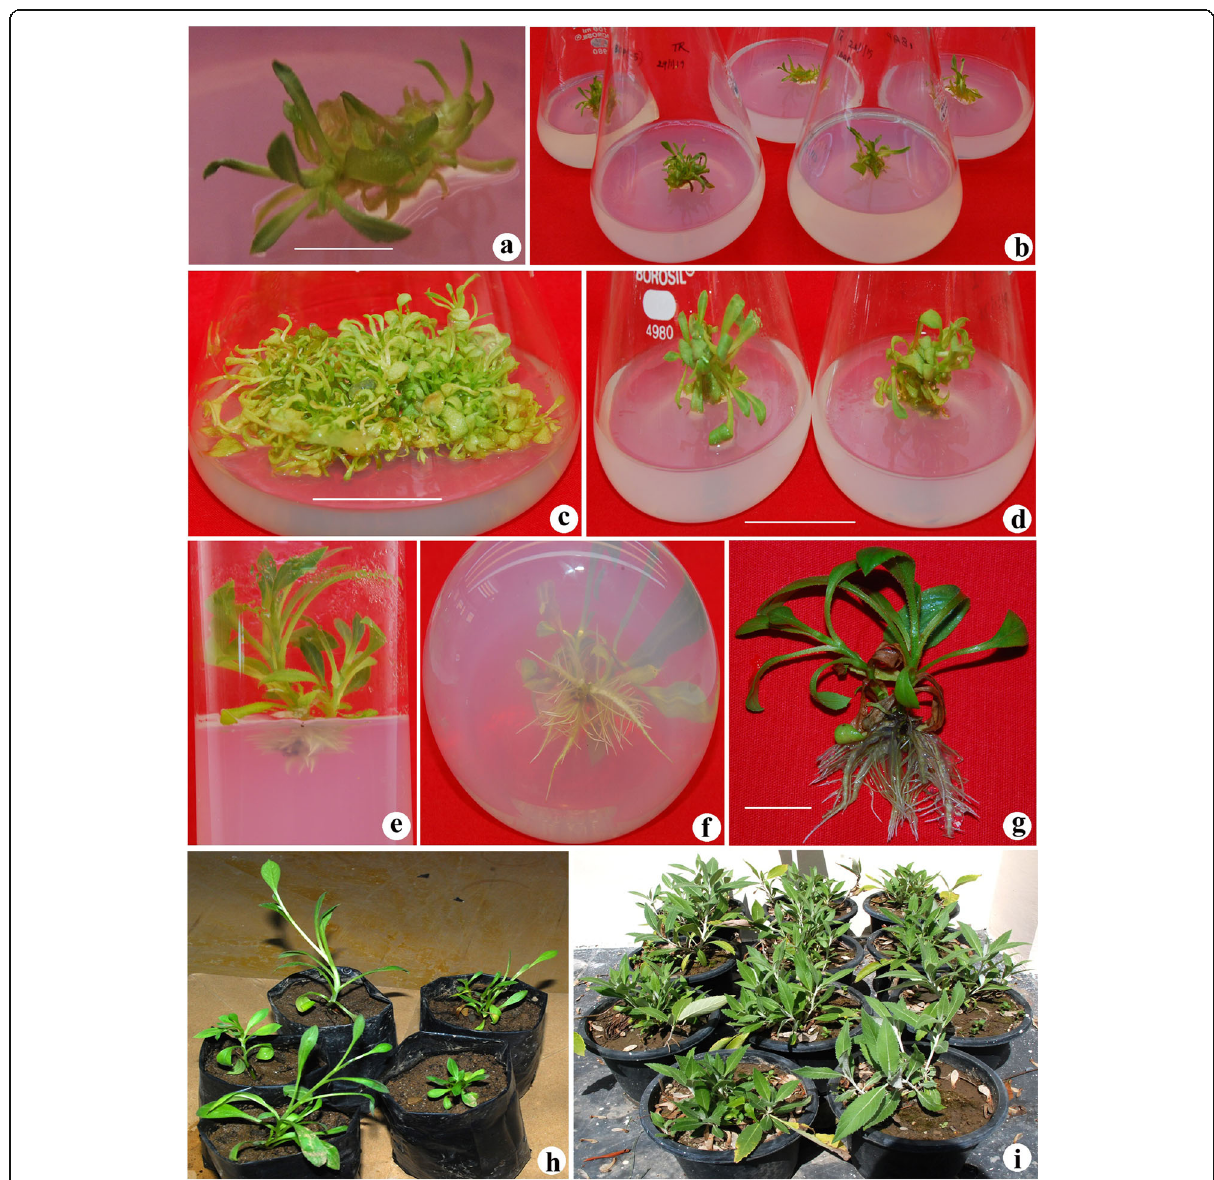
Fig. 2 Micropropagation of Tricholepis roylei . a , b Initiation of shoots from shoot tip explants after 1 week of incubation in half-strength MS medium enriched with BAP (4.4 μ M) plus NAA (1.0 μ M). c Proliferation of shoots in half-strength MS medium containing BAP (4.4 μ M) plus NAA (1.0 μ M). d 6-week-old shoots shifted to half-strength rooting medium. e Initiation of roots after 3 weeks of incubation in half-strength MS medium containing IBA (4.9 μ M). f , g Plantlet with fully developed roots after 8 weeks of incubation. h Hardening of plantlets in plastic bags containing sand. i Fully acclimatized plants transferred to pots containing compost-enriched soil after 4 months. (Bars represent 2